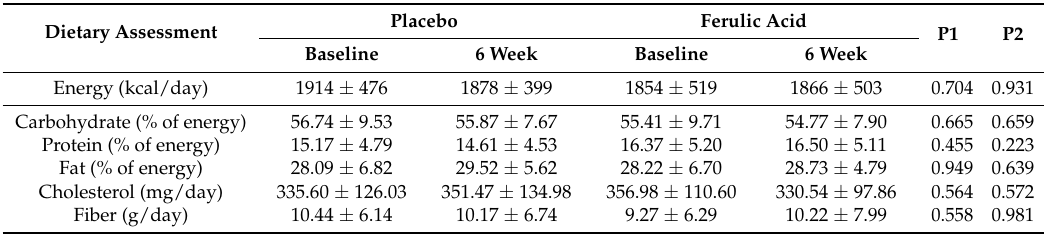
Table 2. Total Energy and Nutrient Intake of Subjects.